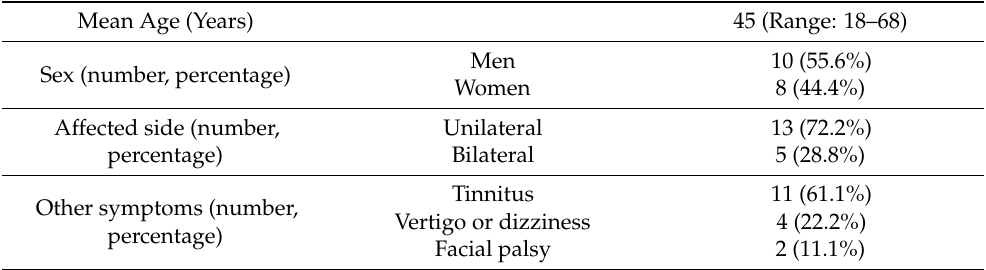
Table 2. Patient demographics in coronavirus disease-related sudden sensorineural hearing loss.